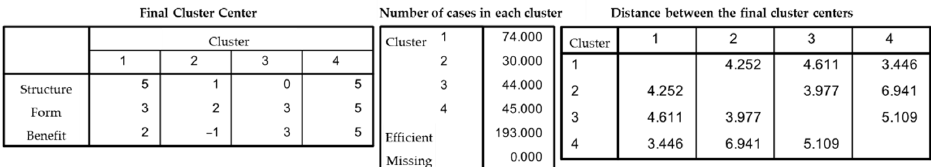
Figure A4. K ‐ means clustering analysis of other buildings after renovation. Figure A5. K ‐ means clustering analysis of changes in the attributes of historical buildings. Figure A6. K ‐ means clustering analysis of changes in the attributes of other buildings. References 1.